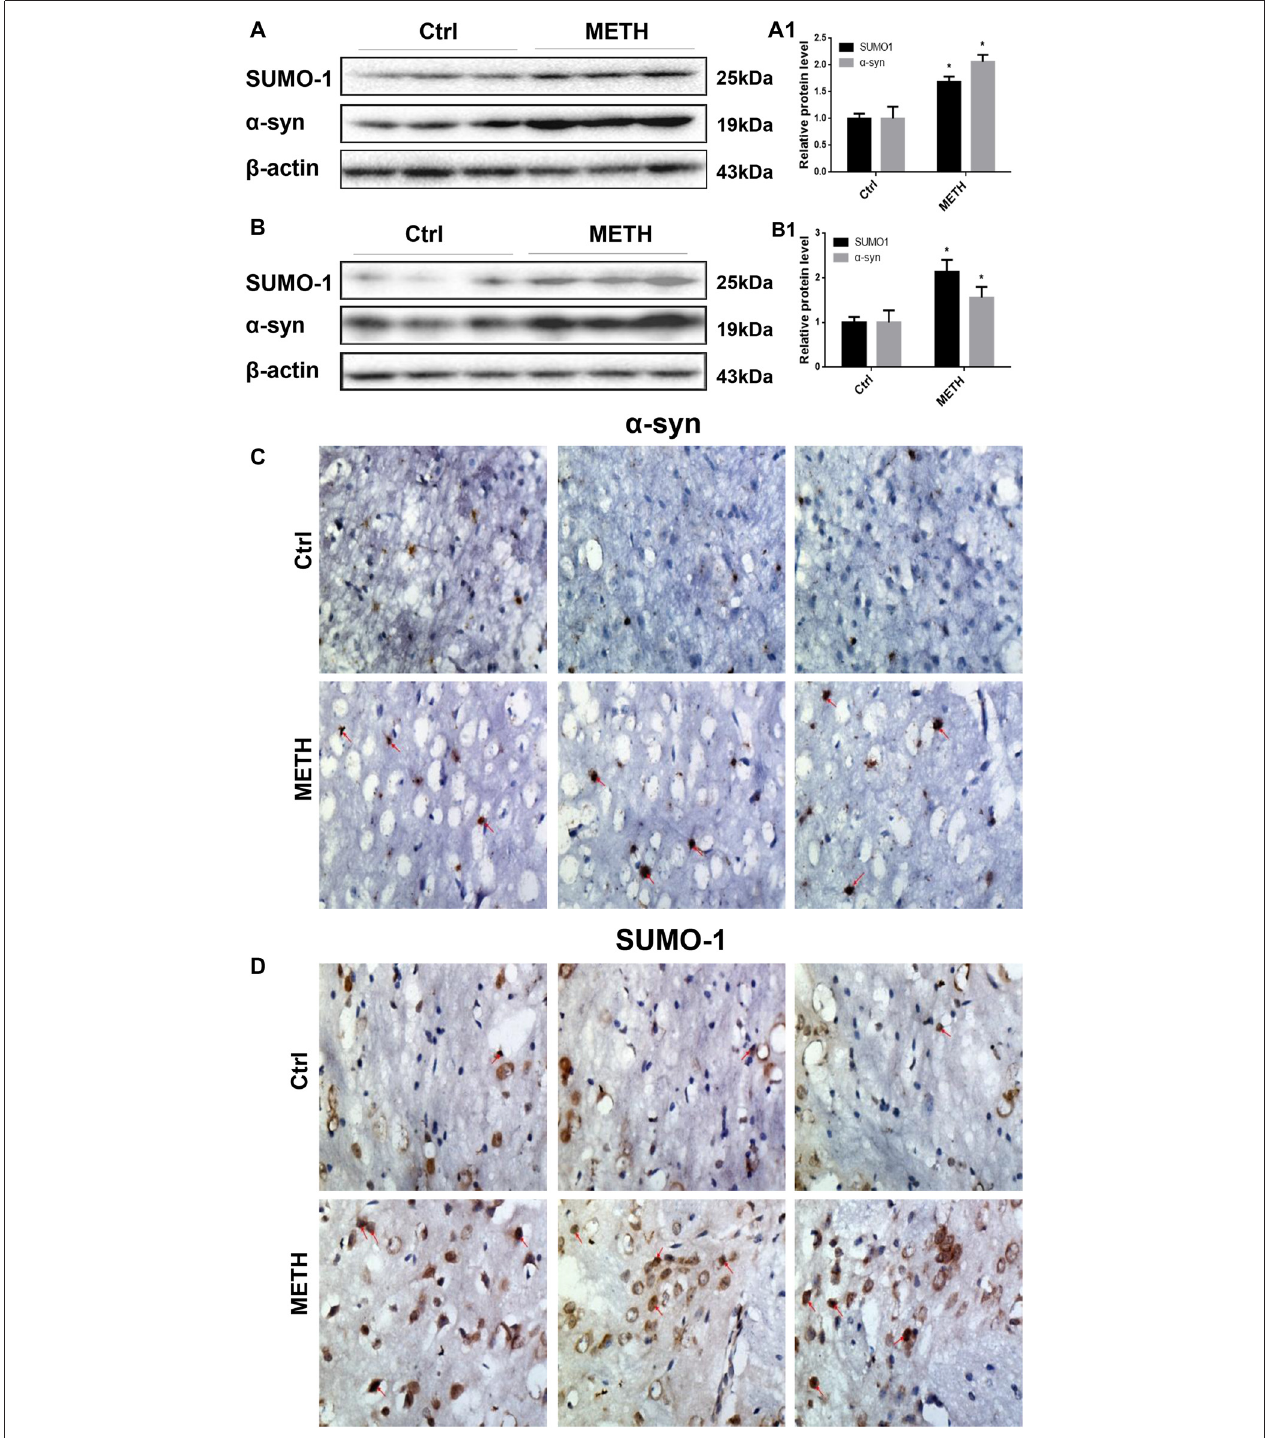
FIGURE 2 | METH increases SUMO-1 and α -syn protein expression in vivo . METH increases SUMO-1 and α -syn expression in the prefrontal cortex (A,A1) and striatum (B,B1) of male C57 BL/6 mice. Male C57 mice were randomly divided into a control group and a subacute group. Western blot (A,B) and quantitative analyses (A1,B1) were performed to determine SUMO-1 and α -syn protein expression in the prefrontal cortex and striatum. Immunostaining of the mouse striatum also showed that SUMO-1 and α -syn expression were increased after METH exposure (C,D) . β -Actin was used as a loading control. ∗ p < 0.05 compared with the control group. The data shown in (A,B) were analyzed using the Mann-Whitney U